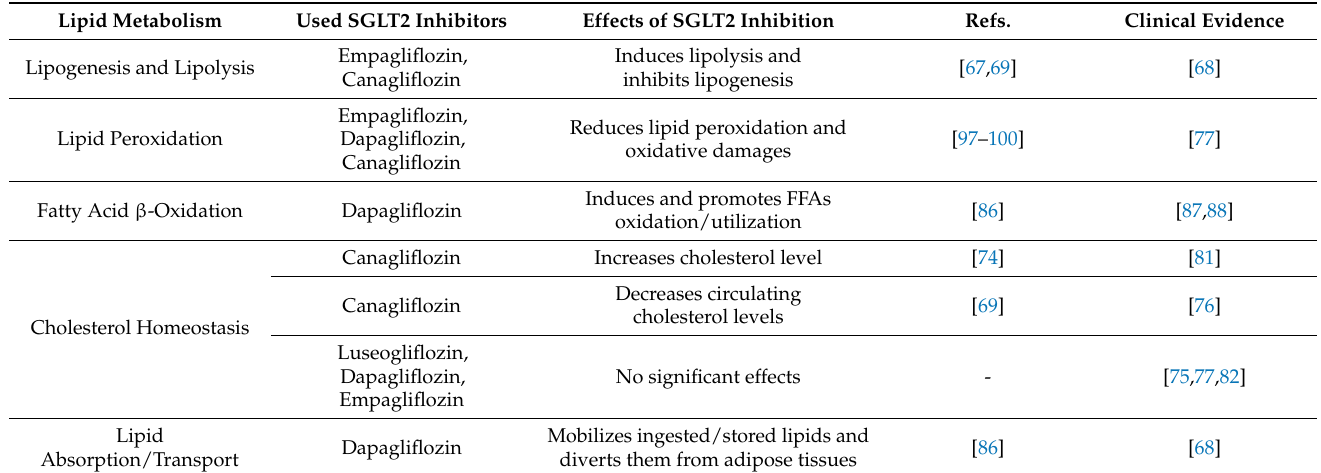
Table 2. The effects of SGLT2 inhibitors on lipid